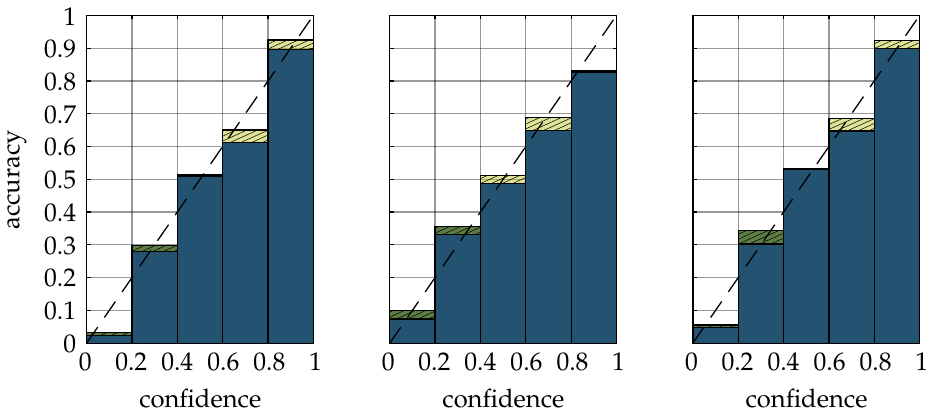
3 from left to right). −